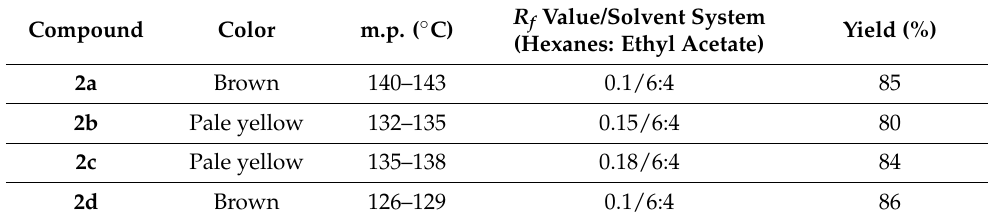
Table 3. Physical data of compounds 2a–d .